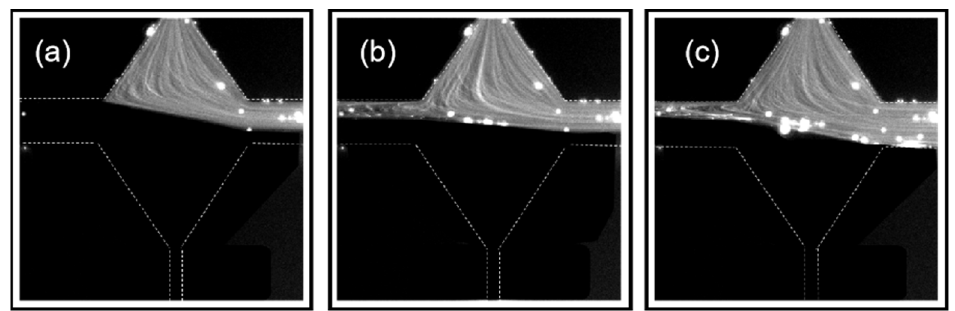
Figure 7. PAM flow pattern in the RCM at Q = 3000 μ L/hour at three different instances. ( a ) fluid with tracer particles only flows to the right outlet; ( b ) fluid with/without tracer particles flows to both outlets; ( c ) fluid without tracer particles only flows to the left outlet.